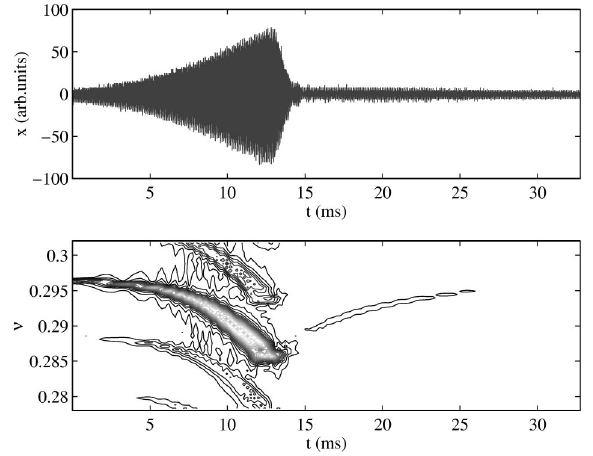
L (cid:1) 2 : 3 m (cid:6) 2 2